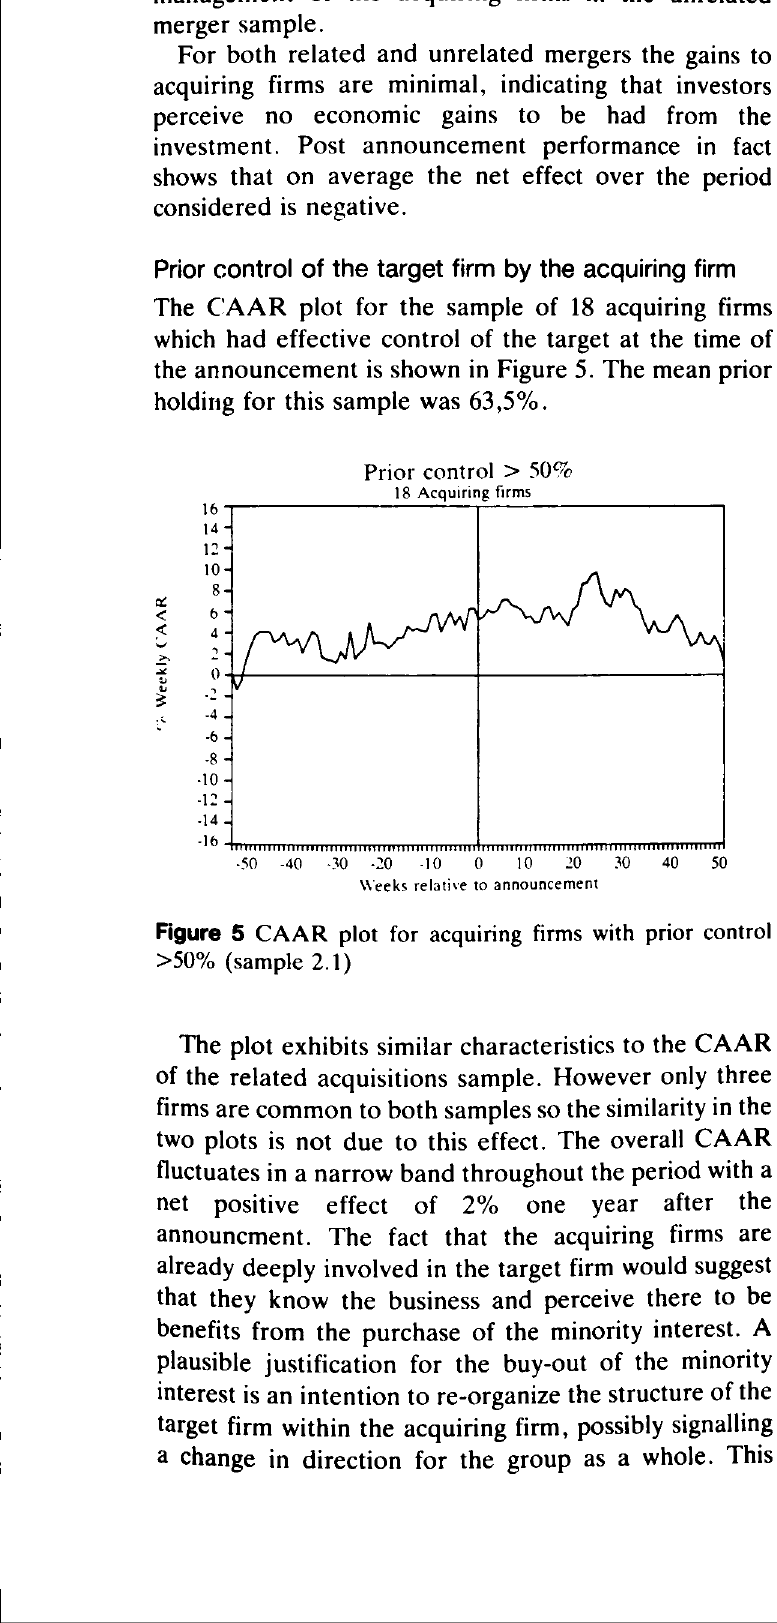
Figure 6 CAAR plot for acquiring firms with prior control <50% (sample 2.2)